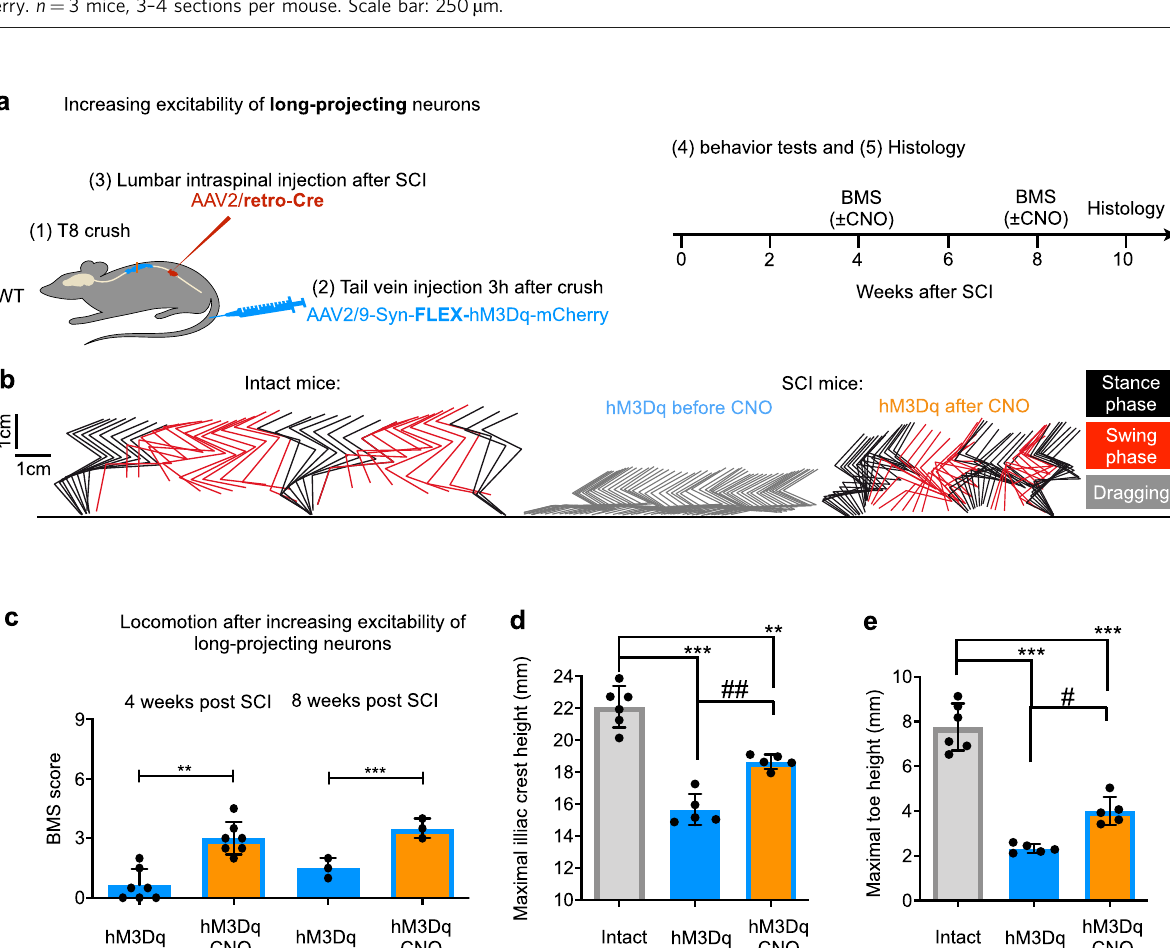
Fig. 4 Inhibition of thoracic inhibitory neurons preferentially improve stepping ability in mice after T8 crush. a Experimental schematic. After a T8 crush injury, Vgat-Cre mice received a tail vein injection of AAV2/9-Syn-FLEX-hM4Di-mCherry. b BMS scores of Vgat-Cre mice with hM4Di expression in thoracic neurons before and 1 h after the application of 5 mg/kg CNO at 4 and 8 weeks past SCI. Data shown as mean ± SD (also for other panels in this fi gure). Two tailed paired t test. *** p < 0.0001 (4 weeks); ** p = 0.0020 (8 weeks). n = 10 (4 weeks) and n = 6 (8 weeks). c Stickviews of detailed kinematic analysis in intact mice and Vgat mice with hM4Di expression in thoracic neurons before and 1 h after CNO (5 mg/kg). The phases of dragging, stance, or swing were marked in indicated colours. Data from intact mice are replotted from Fig. 2c for comparison. d Duration of swing, stance, and dragging phases of different groups of mice. Data from intact mice are replotted from Fig. 2e for comparison. Two tailed sign test was used for within-group comparison (#) and Wilcoxon rank sum was used for between-group comparison (*) n = 6 (intact group) and n = 8 (SCI group). *** p < 0.001. Quanti fi cation of maximum iliac crest heights ( e ) and maximum toe heights ( f ). Two tailed paired t test for within-group comparison (#) and 2 sample ttest for between-group comparison (*). # p = 0.0045 ( e ); 0.0191 ( f ) and *** p < 0.0001. n = 6 (intact) and n = 8 (hM4Di). Data from intact mice are replotted from Fig. 2f, g for comparison. A representative mCherry image ( g ) and average density plot ( h ) of an L2 transverse section showing the distribution of descending projection axons in the lumbar spinal cord in injured Vgat-Cre mice with a tail vein injection of AAV2/9-Syn-FLEX-ChR2-